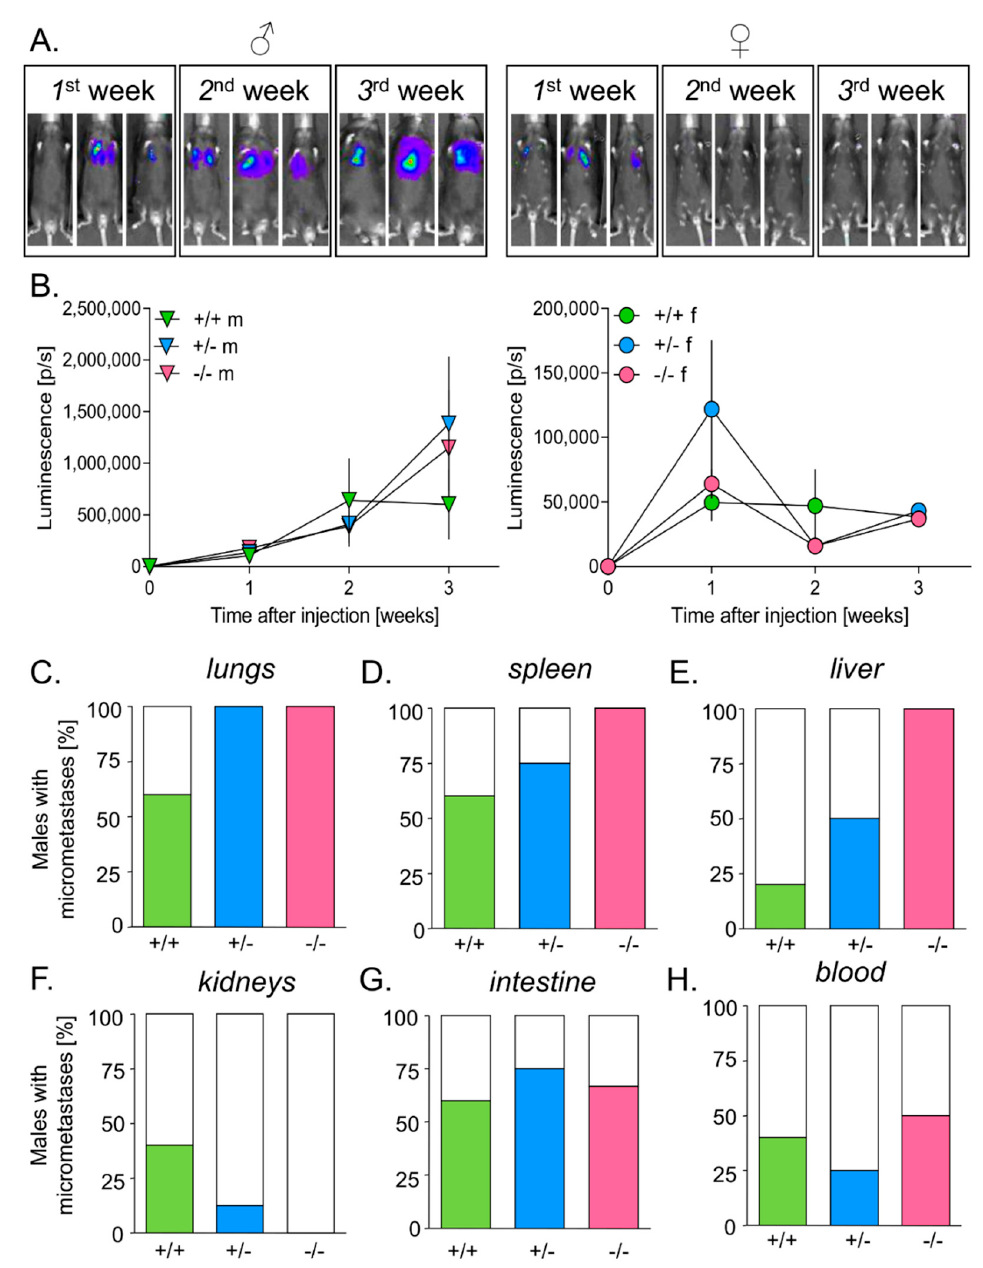
Figure 4. Effect of HO-1 expression in mice on tumor growth in lungs and the presence of micrometastases. ( A ) Tumor growth in males ( ♂ ) and females ( ♀ ) after 1, 2 and 3 weeks. IVIS measurements. Representative pictures. ( B ) Tumor growth in males (m) ( N = 5–8) and females (f) ( N = 6–7) of different HO-1 genotypes: +/+, +/ − or − / − (signal from females is much weaker—please note the scale). Each bar represents mean ± SE. Percentage of males having micrometastases in: ( C ) lungs, ( D ) spleen, ( E ) liver, ( F ) kidneys, ( G ) intestine, and ( H ) blood. Measurements of luciferase activity in tissues’ homogenates.